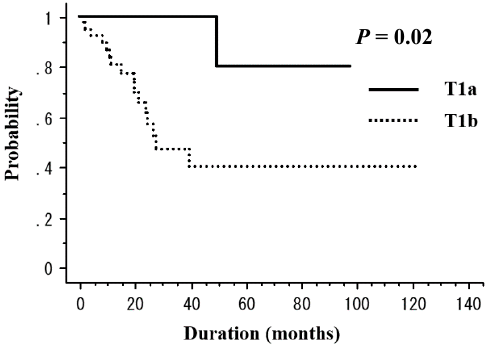
Figure 2. The disease ‐ free survival (DFS) rate according to the T stage. The DFS rates are 100% in patients with T1a tumors and 47.1% in those with T1b tumors at 3 years ( p = 0.02).